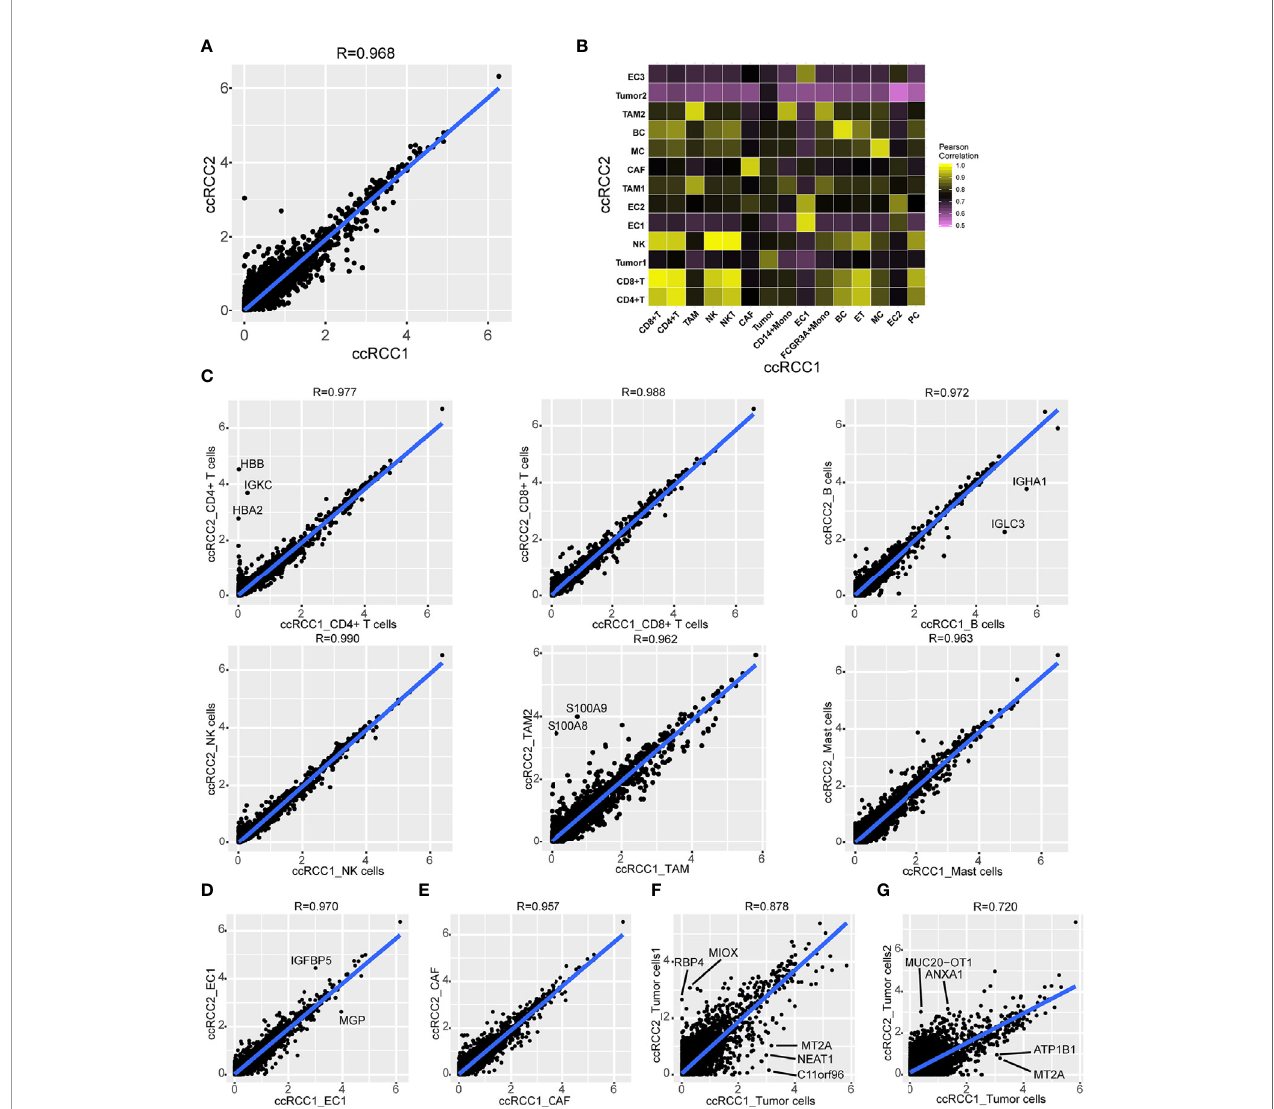
FIGURE 5 | Comparison of gene expression in bilateral renal tumours. (A) Scatterplot showing the log1p of the average expression (AE) per gene in total ccRCC1 (horizontal) and ccRCC2 (vertical). Pearson ’ s correlation coef fi cient was 0.968 (R=0.968). (B) Heat map indicating Pearson correlations on the averaged pro fi les among each cell type for ccRCC1 (horizontal) and ccRCC2 (vertical). (C, G) Scatterplot showing the log1p of the average expression (AE) per gene of CD4 + T cells (C) , CD8 + T cells (C) , B cells (C) , NK cells (C) , TAM (C) , mast cells (C) , endothelial cells (EC , D ), CAF (E) and tumour cells (F, G) in ccRCC1 (horizontal) and ccRCC2